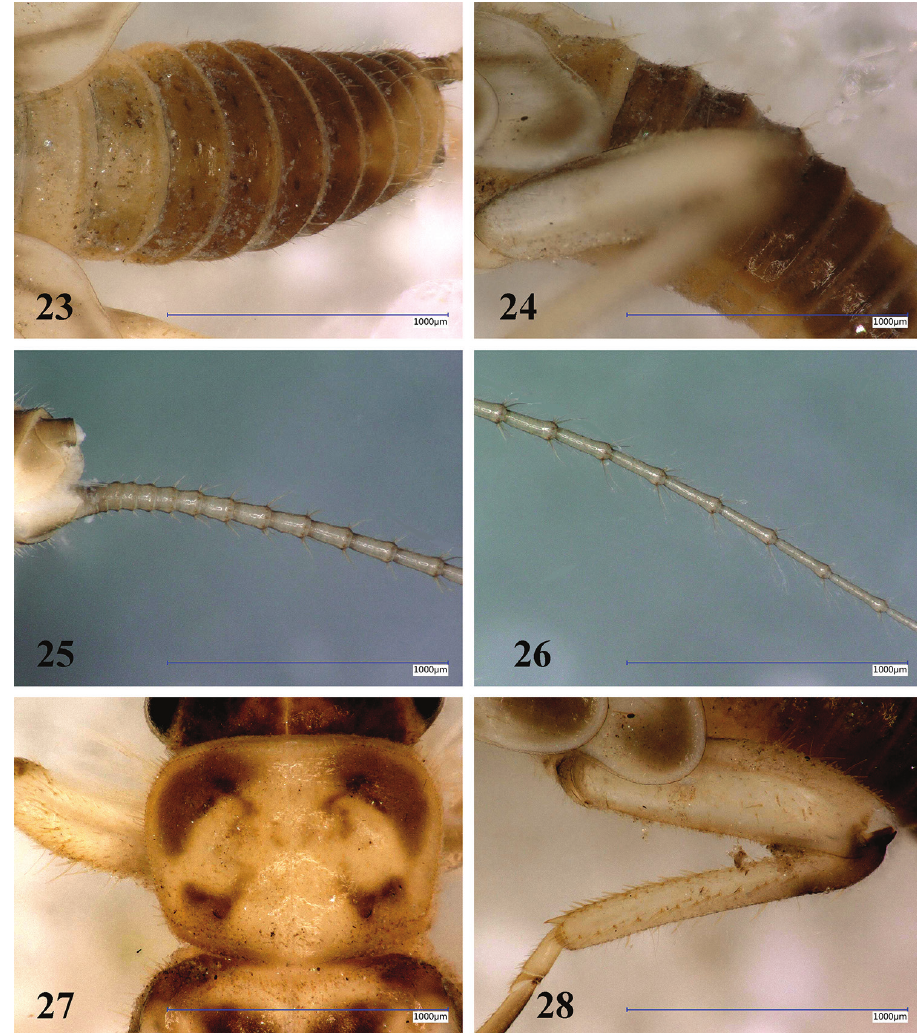
Figures 23–28. Amphinemura dingoidea sp. n., matured larva paratype. 23 Abdomen, dorsal view 24 Terga I–VII, lateral view 25 Paraproct and basal half of cerci, oblique ventral view 26 Cercomeres 14–21, oblique ventral view 27 Pronotum, dorsal view 28 Left hind leg, outer face. Scale bar: 1 mm. same data as holotype: 2 females, 1 male larva (HIST), 1 male, 2 females